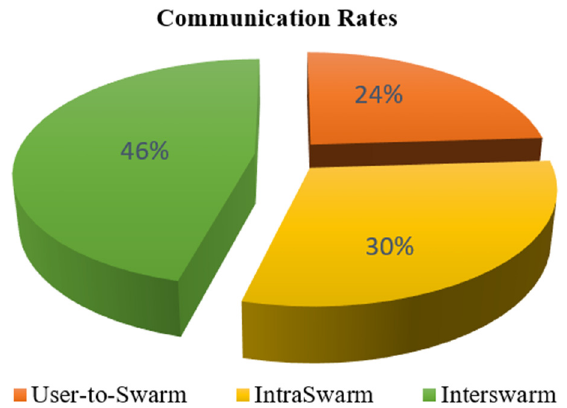
Figure 4. Communication models used in swarm robotics [26].